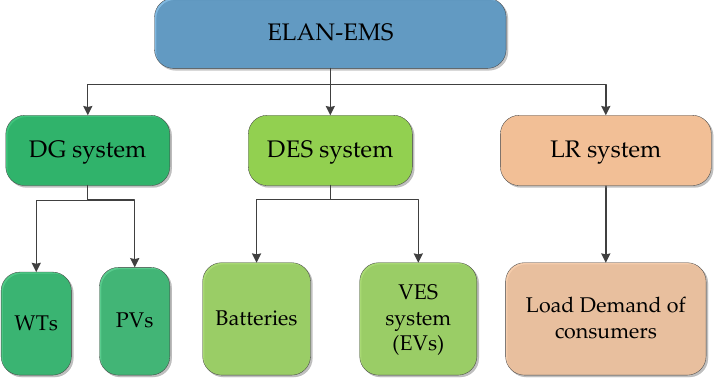
Figure 3. The framework of ELAN-EMS.